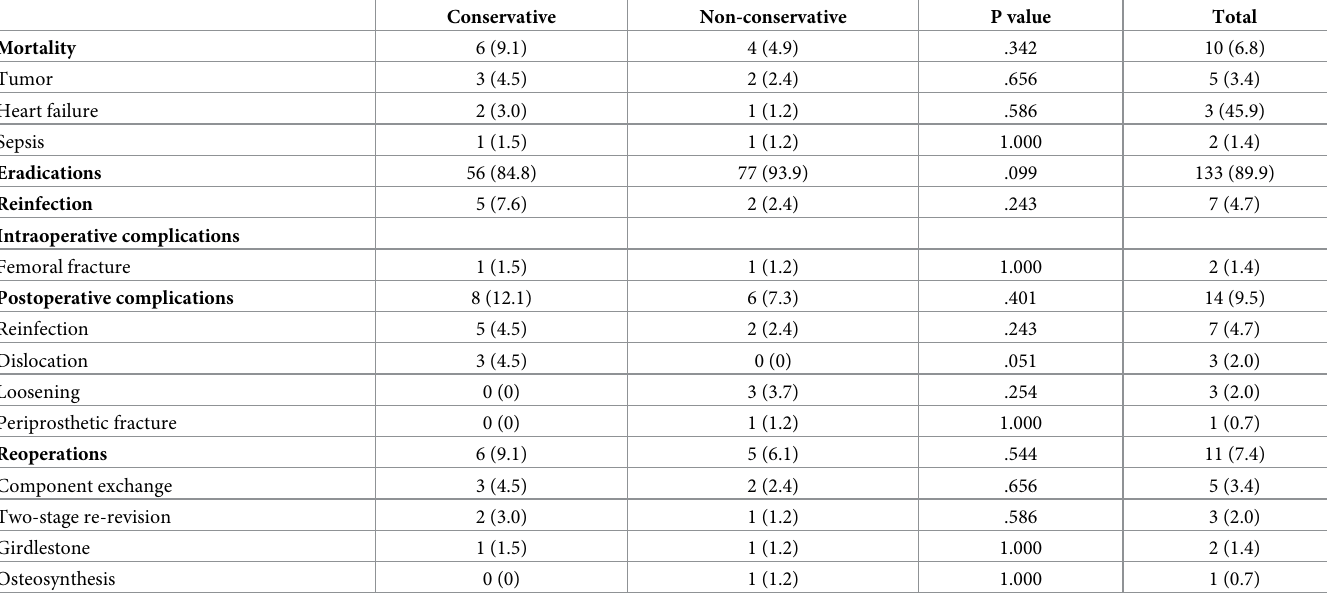
Table 3. Results of two-stage revision for hip